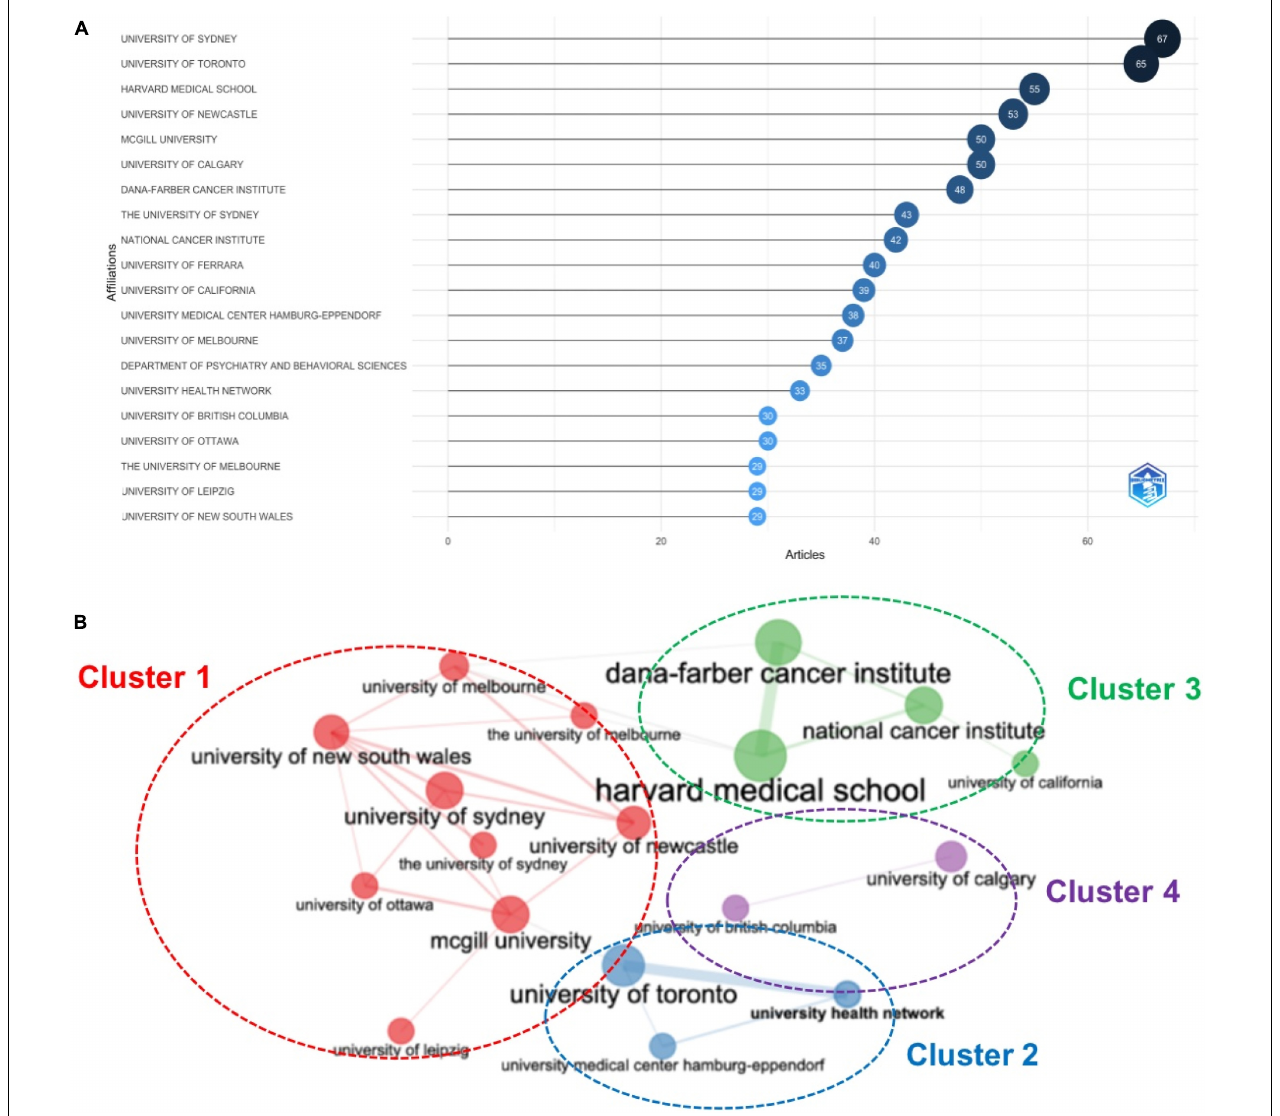
FIGURE 4 | (A) Top 20 leading institutions in psycho-oncology research between 1980 and 2021, (B) Institutions collaboration network.